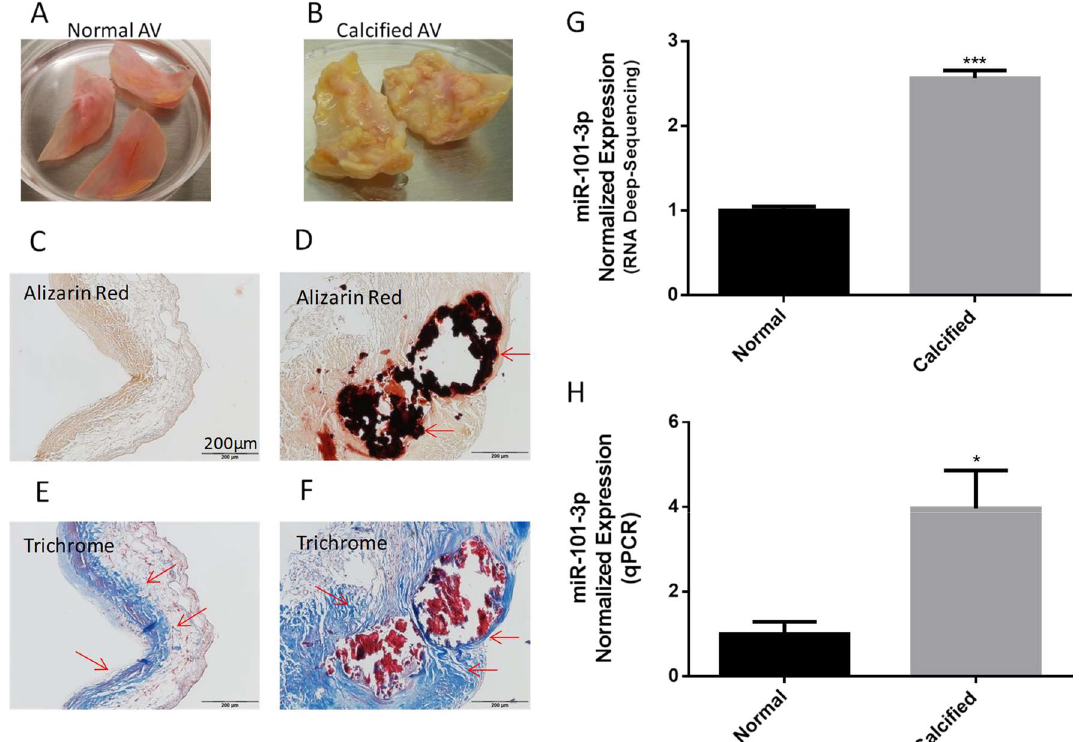
Fig. 1 miR-101-3p expression was upregulated in the calcified human aortic valves. A , B Photomicrographs of freshly isolated normal and calcified human aortic valves. C , D Alizarin red staining of normal and calcified human aortic valves, red staining indicating calcification (indicated by arrows). E , F Masson’s Trichrome staining of collagen deposition (blue staining indicated by arrows) of normal and calcified human aortic valves. G Small RNA deep sequencing results of miR-101-3p of normal and calcified human aortic valves. Data qPCR analysis of miR-101-3p of normal and calcified human aortic valves. Scale bar